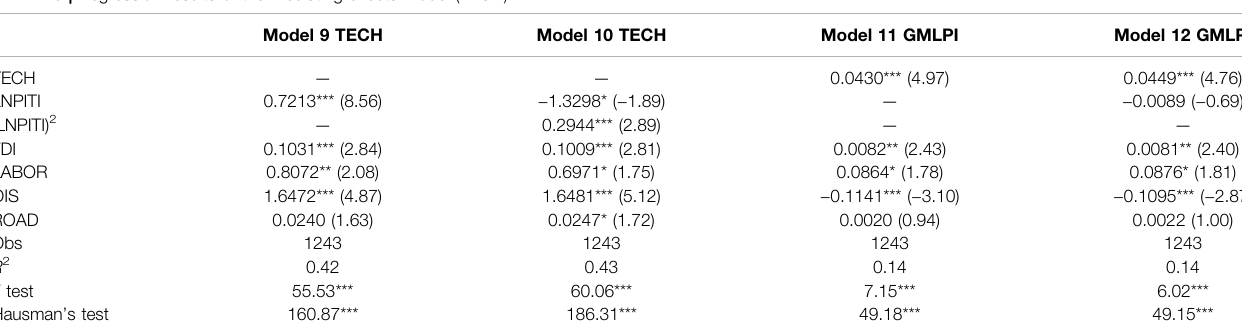
TABLE 3 | Regression results of the mediating effects model